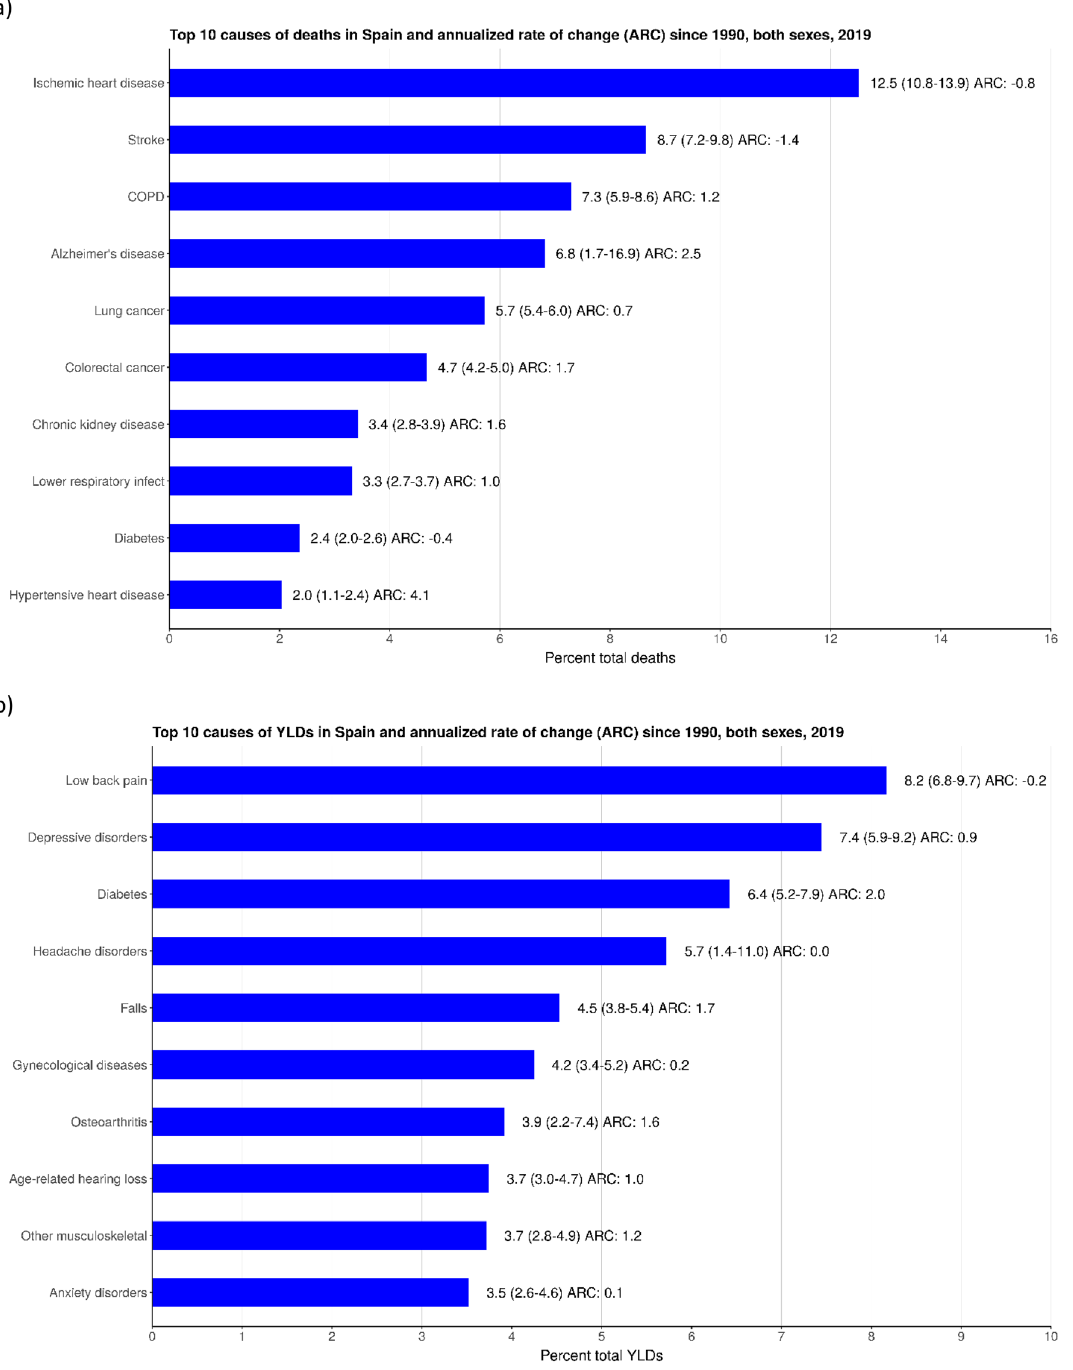
Figure 2. Top 10 causes of: ( a ) deaths; ( b ) years lived with disability (YLDs); ( c ) disability-adjusted life years (DALYs); and d) years of life lost (YLLs) in Spain and ARC (%), 2019. COPD, chronic obstructive pulmonary